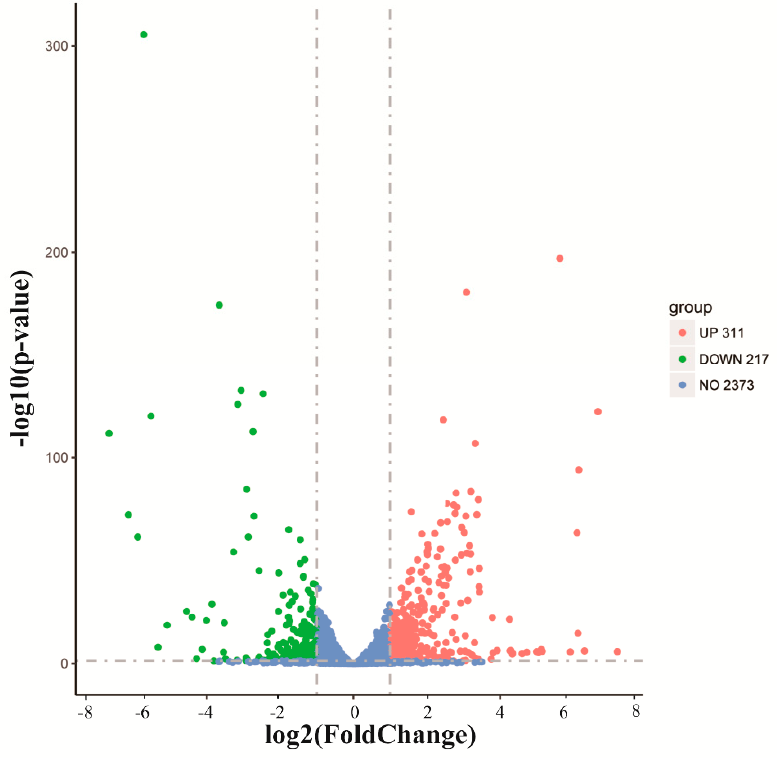
Figure 5. Analysis of deferentially expressed genes. The transcription data from the MEL-A-treated cells were compared to those from the control condition. The genes with a p -value < 0.05 and |log2(FoldChange)| > 1 were considered differentially expressed genes (DEGs). Red dots indicate upregulated DEGs, green dots indicate downregulated DEGs and the blue dots indicate genes with no significant changes in expression.